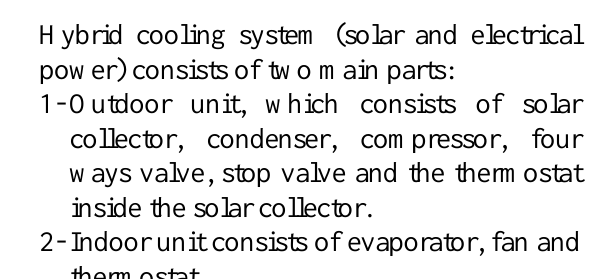
Fig. 5: diagram for hybrid cooling system